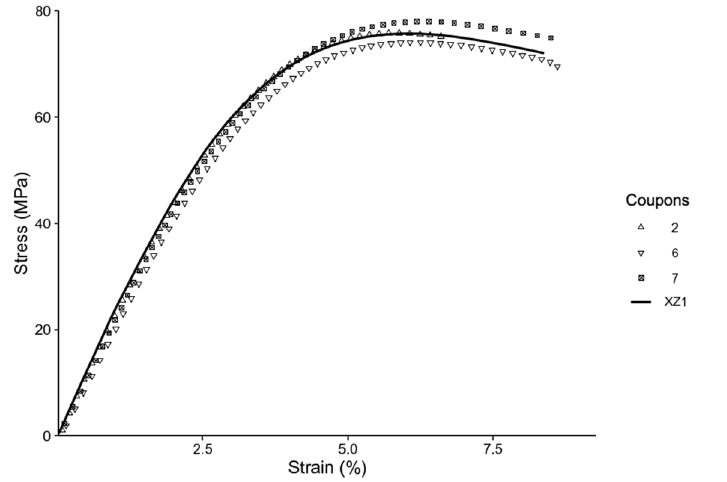
Figure 9. Stress–Strain curve for coupons printed in XZ, annealed (2,6,7), and controls (XZ1).